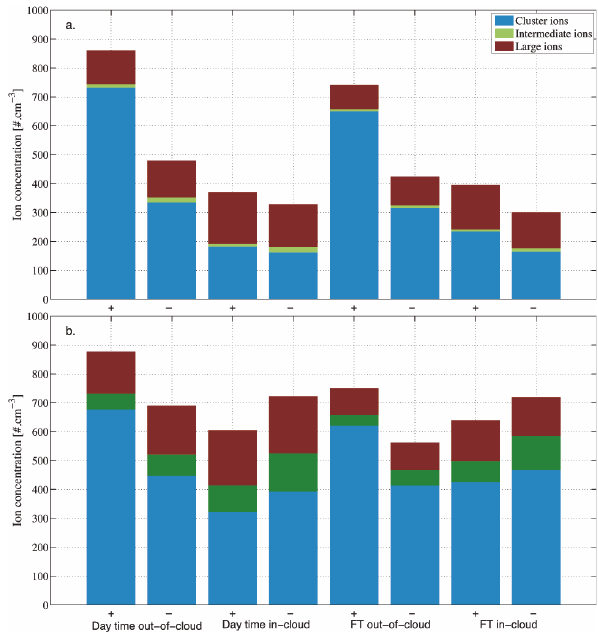
Fig. 4. Monthly frequencies of nucleation/new particle formation events. Grey bars: events according to the total number of days; blue bars: events according to the number of clear sky